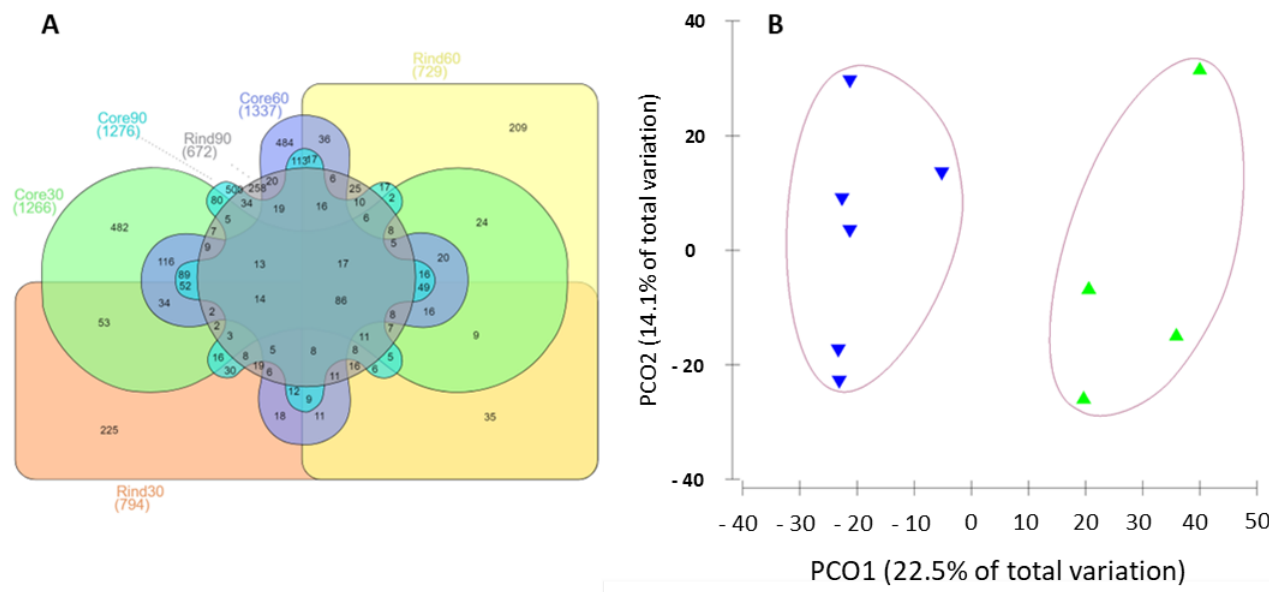
Figure 3. Metaproteomics dataset. ( A ) The identified proteins. The Venn diagram displays the number of proteins identified in each of the sample groups taken into consideration in the present study. Specifically, the diagram shows the size of the metaproteome identified in the rind and core samples at the ripening timepoints of 30, 60, and 90 days. ( B ) The ordination of the dataset in a PCO plot, highlighting the clear separation of the rind and core samples according to their identified protein repertoires.